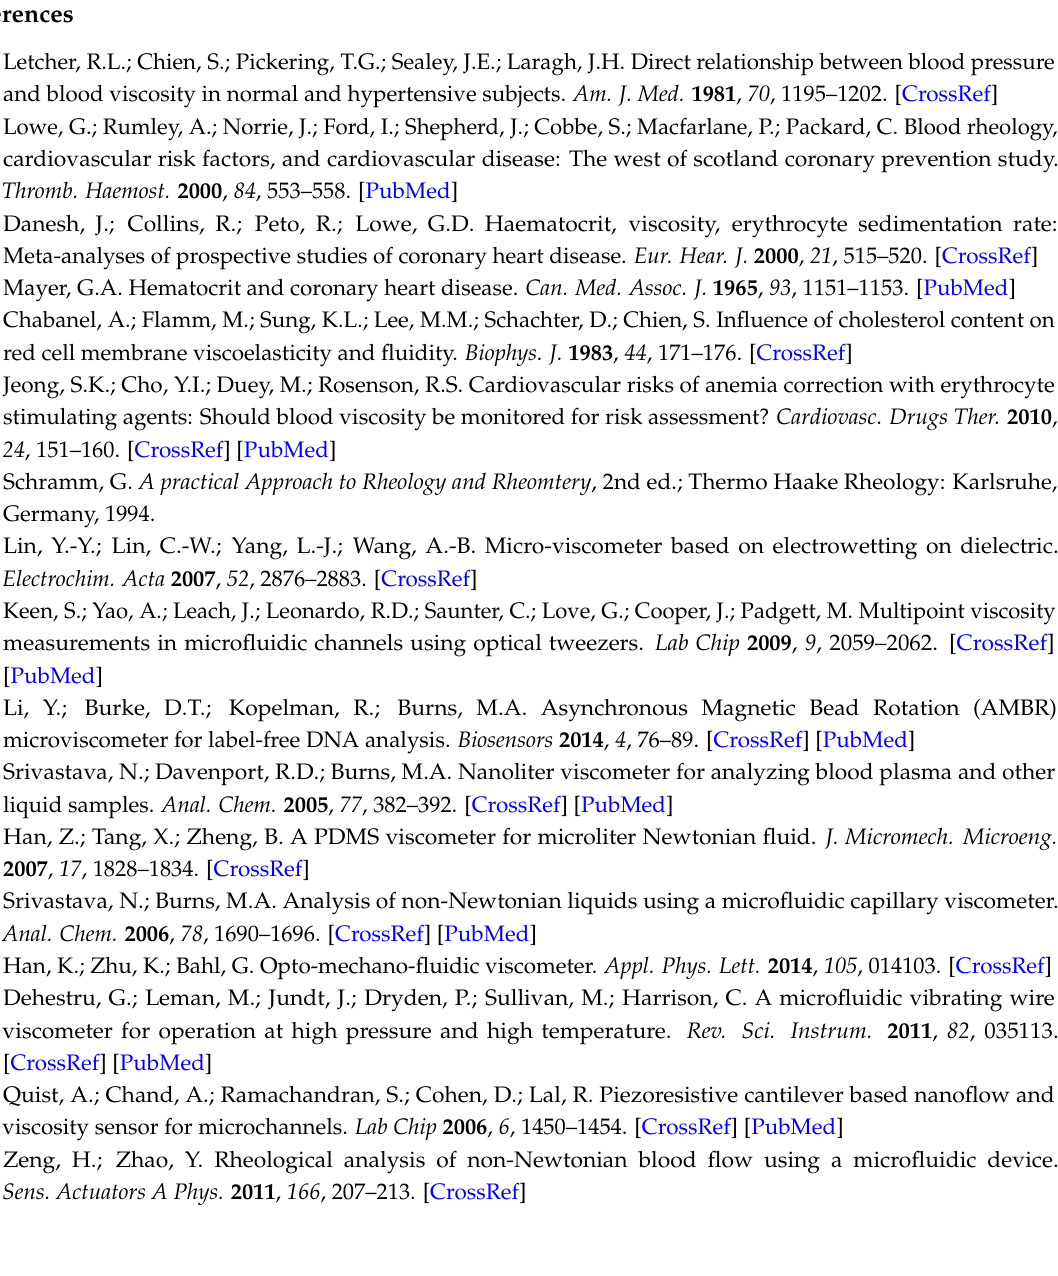
Figure S1: Experimental demonstration of the micro-viscometer using a Newtonian fluid. Viscosity of the 8% SDS solution is obtained by the micro-viscometer (red circle) and the rotational viscometer (white circle). For the rotational viscometer, the averaged viscosity of 20 data points under 17.3–1000/s in shear rate is 1.88 cP. For the micro-viscometer, the averaged viscosity under 21.9–1505.9/s in shear rate is 1.78 cP. It shows good agreement compared to the result from the rotational viscometer (4.3% in relative error). In addition, it is demonstrated that the proposed micro-viscometer can measure the shear-independent viscosity of the Newtonian